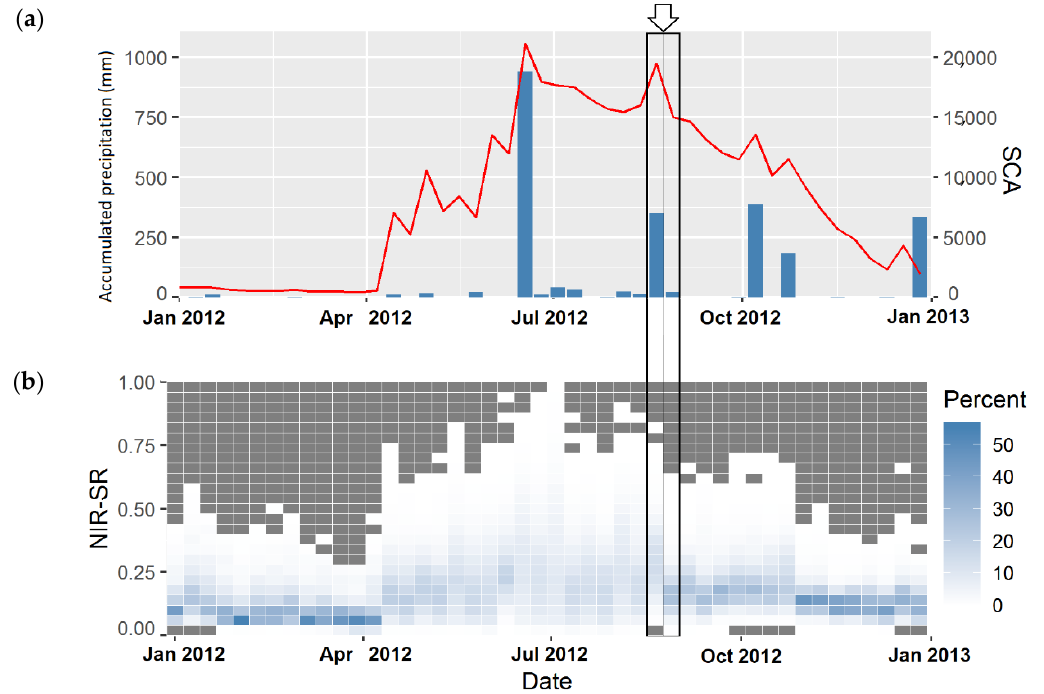
Figure 4. An example of the analysis done with ( a ) SCA (red line), ( b ) NIR-SR (heatmap) and precipitation events (blue bars) for the Maipo basin in the year 2012.